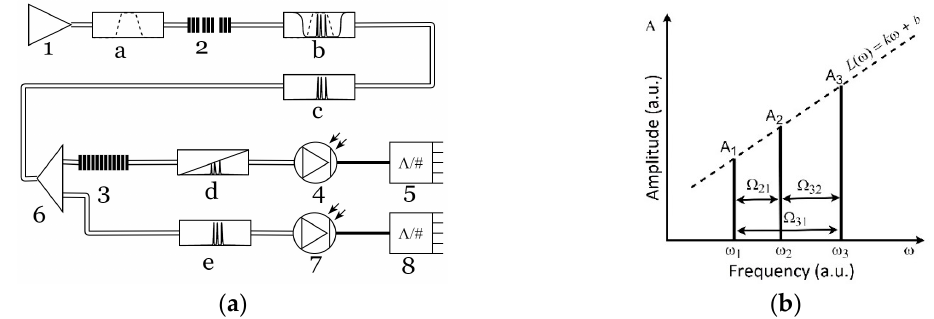
Figure 2. Multi-Addressed Fiber Bragg Structure: ( a ) a microwave-photonic interrogation scheme; ( b ) a spectral response of Multi-Addressed Fiber Bragg Structure. ( b ) a spectral response of Multi-Addressed Fiber Bragg